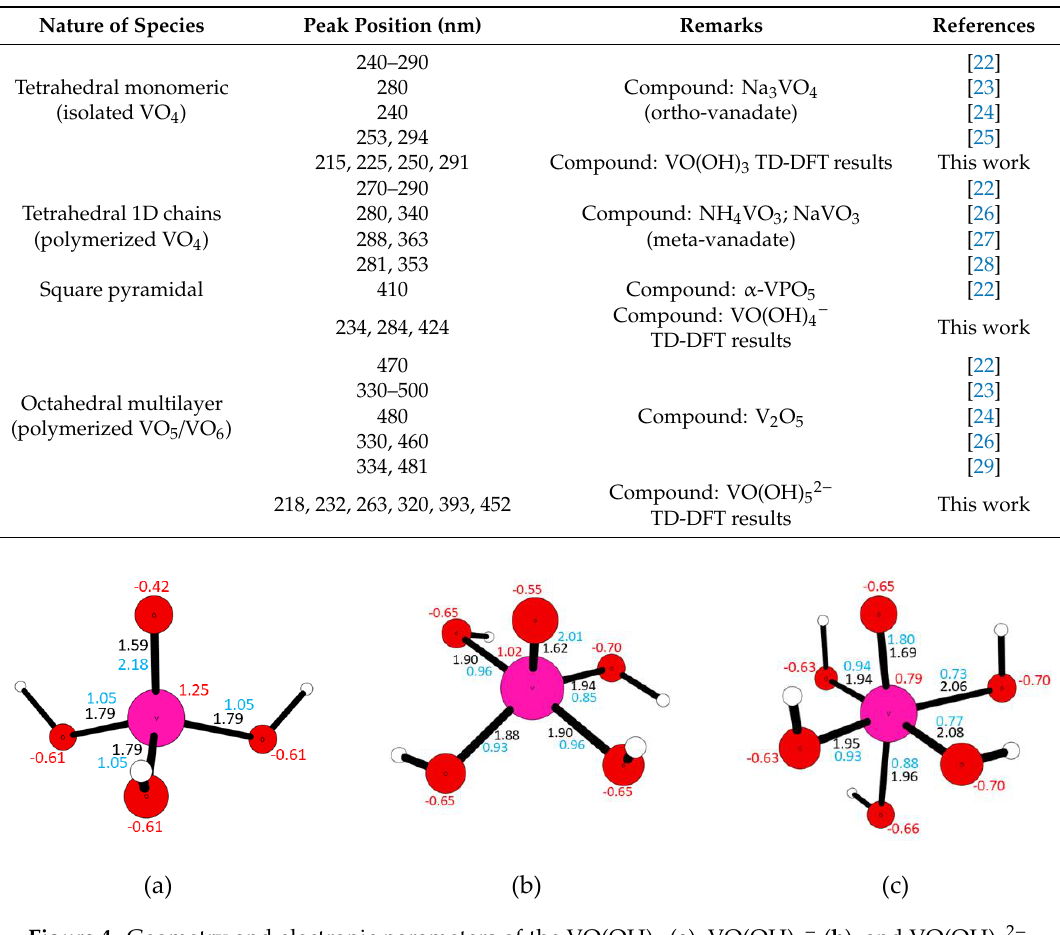
Figure 4. Geometry and electronic parameters of the VO(OH) 3 ( a ), VO(OH) 4- ( b ), and VO(OH) 52- ( c ) complexes. Table 3. Time-dependent density-functional theory (TDDFT) (PBE/def2-TZVP) absorption peak positions for model V compounds and the reference experimental UV-VIS peak positions for vanadium systems.